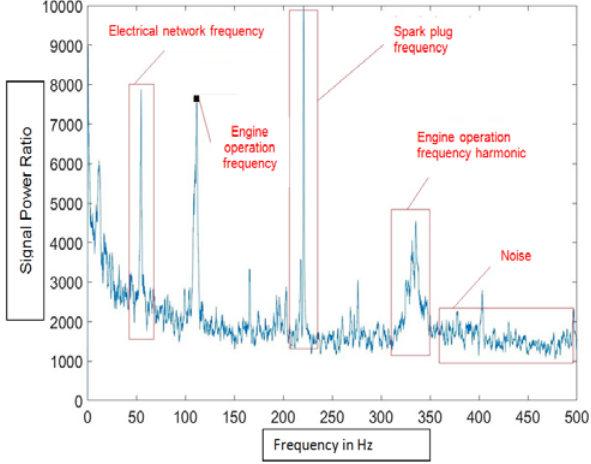
Fig. 6. Spectral analysis of signal from actual temperature thermocouple